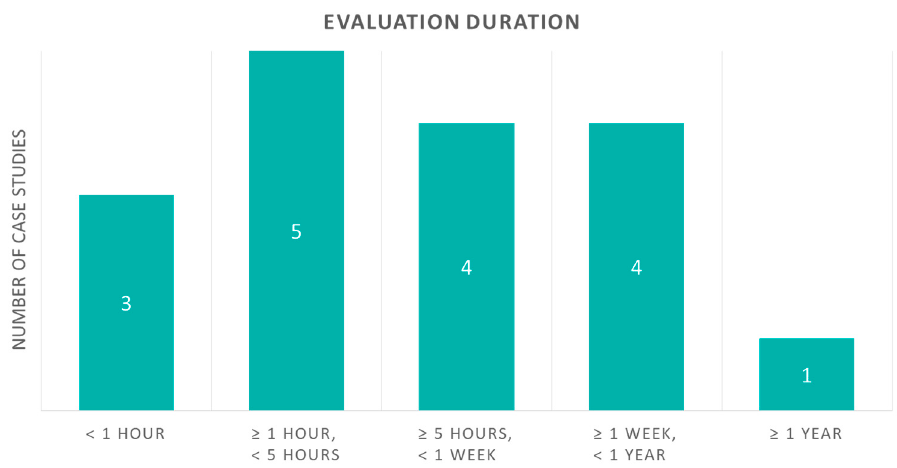
Figure 9. Case studies with evaluation according to their duration.